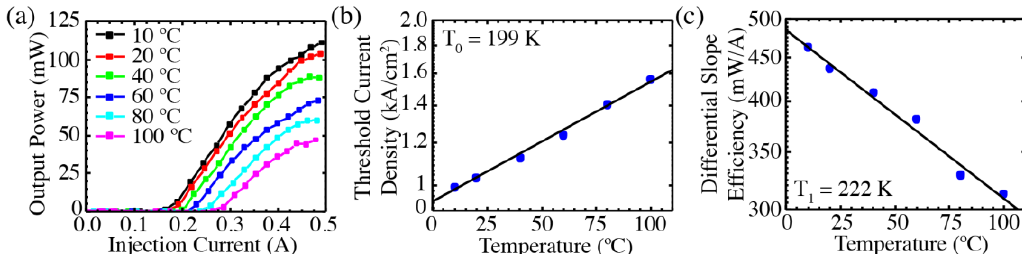
Figure 8. ( a ) Pulsed output power for a laser of Design B at temperatures ranging from 10 °C to 100 °C; ( b ) Corresponding threshold current density vs. temperature, which yields a characteristic temperature of T 0 = 199 K; ( c ) Corresponding differential efficiency vs. temperature, which yields a characteristic temperature of T 1 = 222 K.